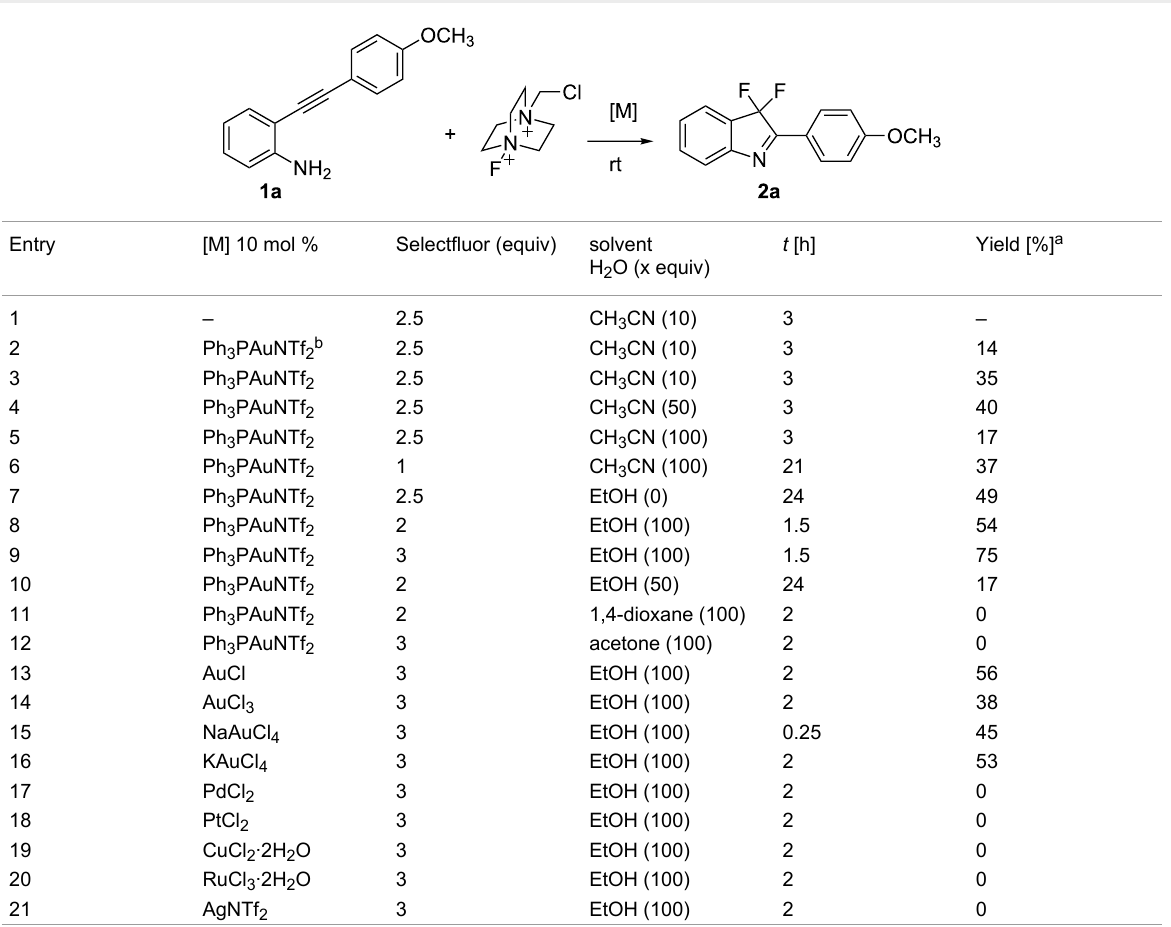
Table 1: Cycloisomerization/fluorination of 2-{[4-(methoxy)phenyl]ethynyl}aniline ( 1a ).